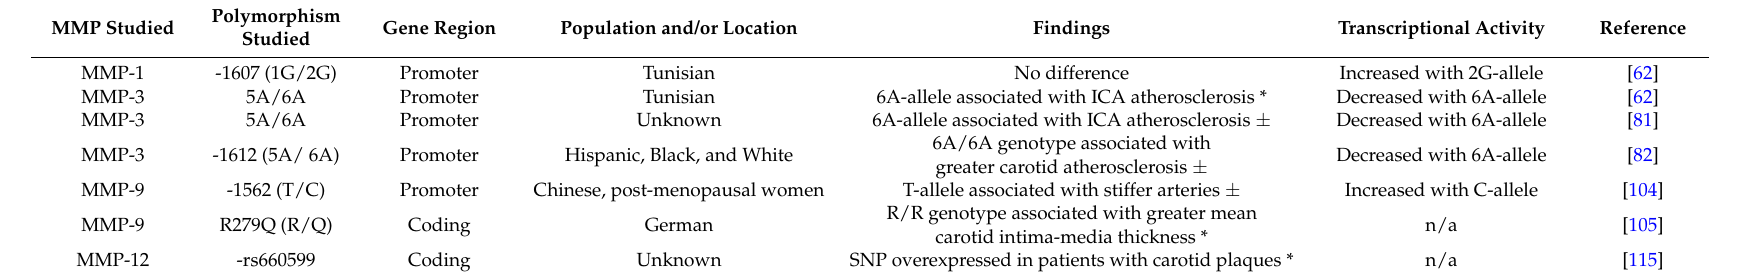
Table 1. Matrix metalloproteinase (MMP) polymorphism relation to carotid artery atherosclerosis and intima-media thickness.